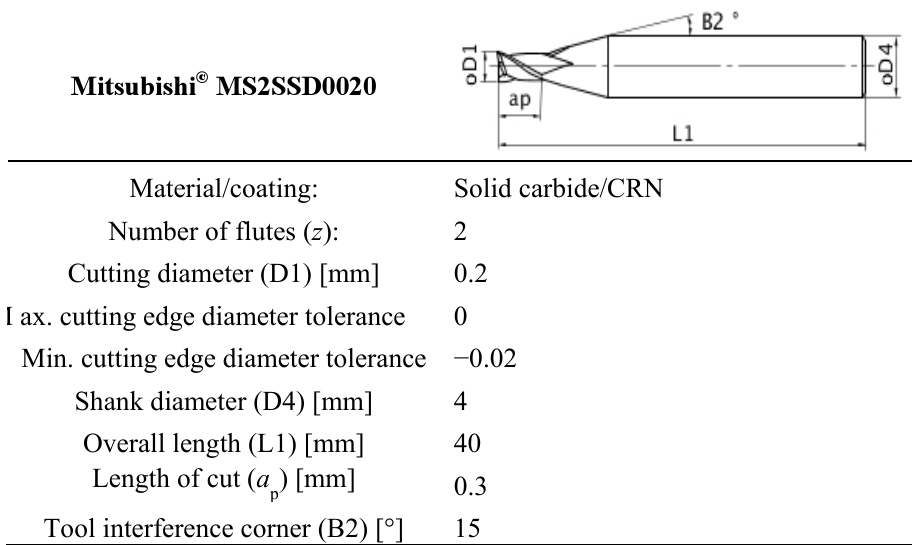
Table 2. Tool geometric characteristics.